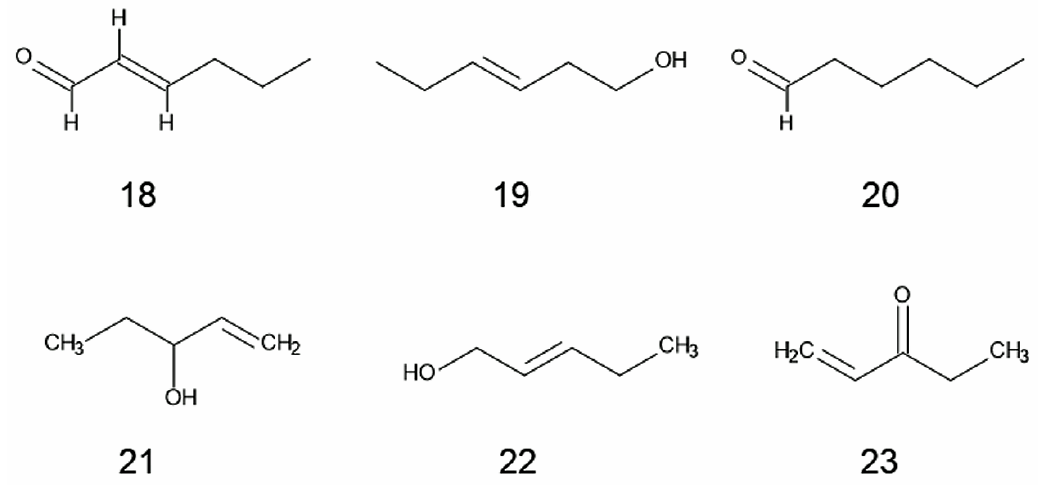
Figure 2. Volatile compounds found in the leaf extracts of Japanese knotweed. 279